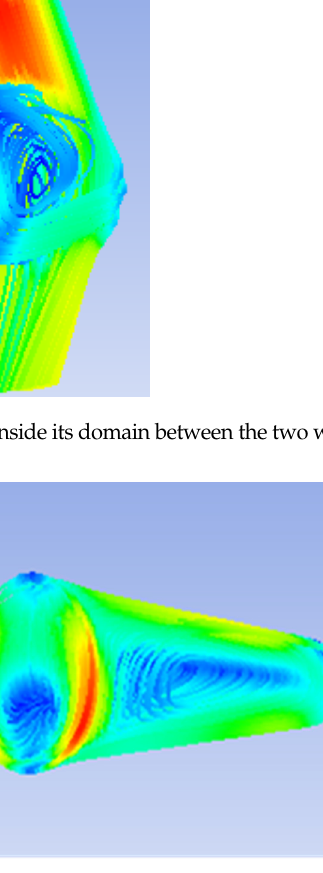
Figure 5. Velocity of the liquid target inside the target cavity with standard initial conditions.